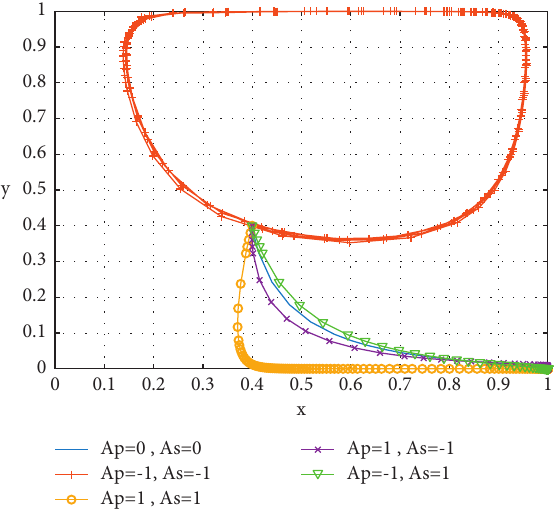
Figure 8: Evolution results with the change of risk attitudes by the initial values in Case